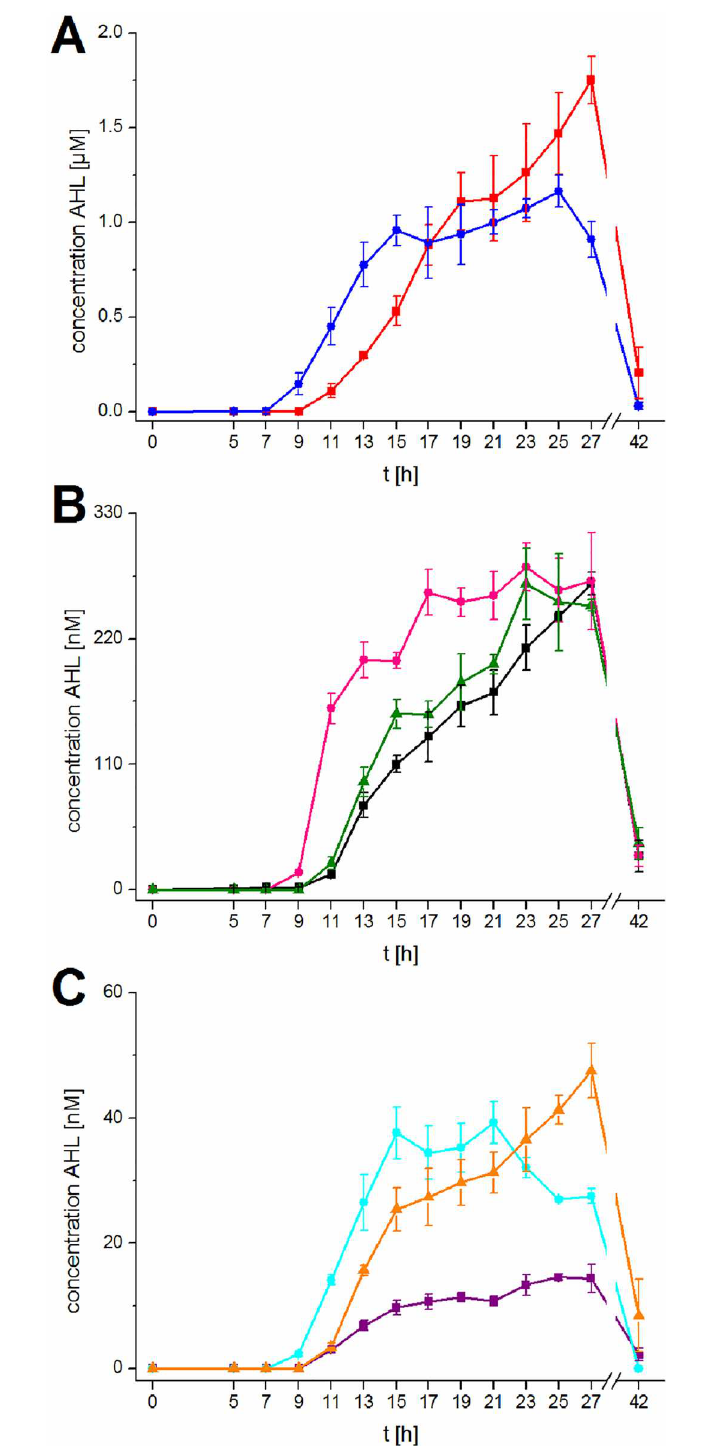
Fig 4. Production of AHLs in PB-St2; quantified using LC-MS/MS precursor ion scans and calibration curves. (A) 3-OH-C6-HSL (red, quantification was possiblebetween5 and 42 h) and 3-oxo-C6-HSL (blue, quantification was possiblebetween5 and 42 h). (B) C4-HSL (black, quantification was possiblebetween5 and 42 h), C6-HSL (pink, quantification was possiblebetween9 and 42 h), and 3-OH-C8-HSL (green, quantification was possiblebetween11 and 42 h). (C) C8-HSL (purple, quantification was